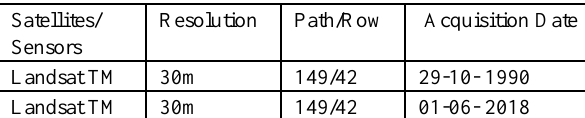
Table 3: Characteristics of Satellite Data Used.